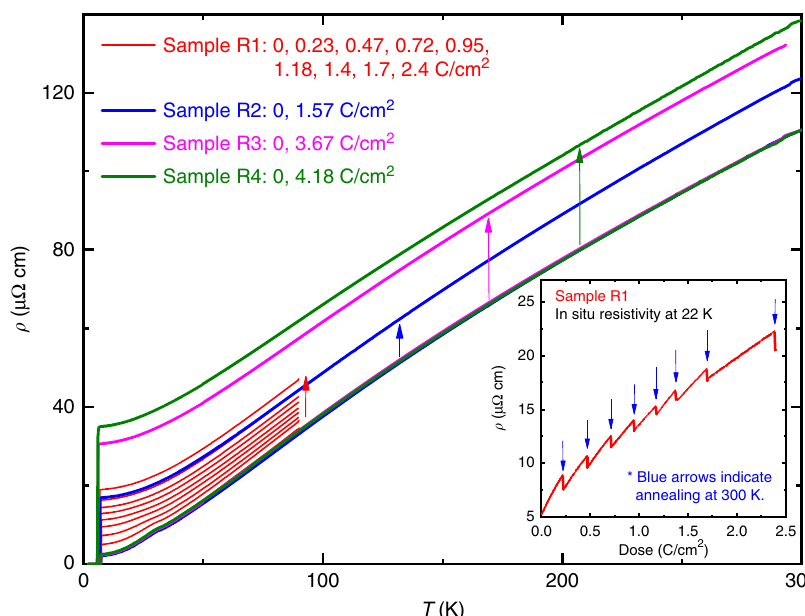
Fig. 1 Temperature dependence of resistivity upon electron irradiation. Resistivities of four different samples: R1 (0, 0.23, 0.47, 0.72, 0.95, 1.18, 1.4, 1.7, and 2.4 C cm − 2 ), R2 (0, 1.57 C cm − 2 ), R3 (0, 3.67 C cm − 2 ), and R4 (0, 4.18 C cm − 2 ). Note that all 0-dose curves for samples R1, R2, R3, and R4 are coincident. Overall resistivity increase with increasing dose was consistently seen for all samples, as shown by the arrows. The inset shows in-situ measurement of resistivity of sample R1 as a function of dose during electron irradiation at 22 K. The blue arrows indicate stops in irradiation, during which the sample was extracted from the irradiation chamber and characterized. Partial annealing of about 30 – 40% of resistivity increase occurred on warming the sample to room temperature and subsequently cooling down to 22